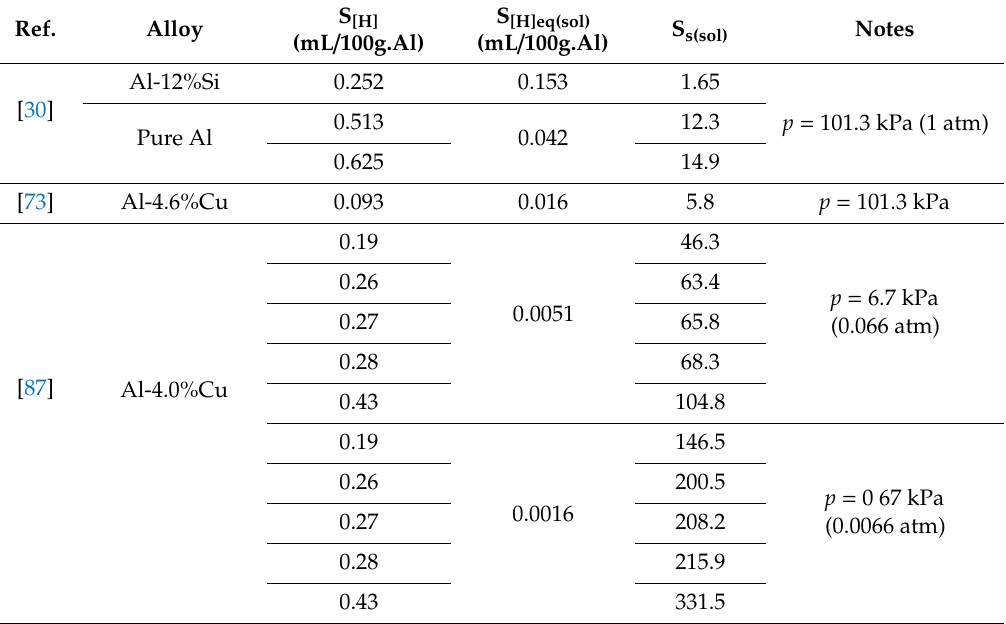
Table 1. Extreme data from the literature in which no pores were detected along with the associated hydrogen level, calculated hydrogen solubility and hydrogen supersaturation in solid aluminum.